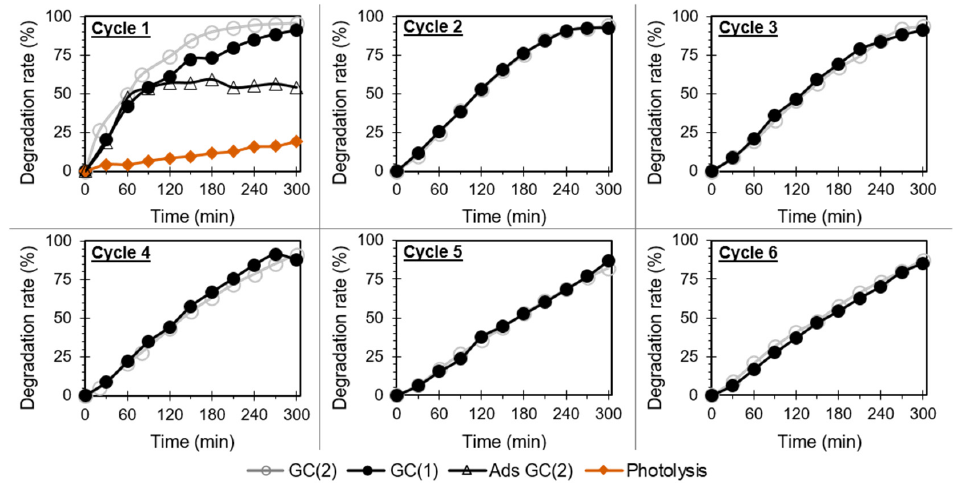
Figure 4. Photolysis degradation rate, adsorption rate in the dark (Ads), and photocatalysis degrada- tion rate as a function of time for MO under artificial solar light in the presence of GC(2) or GC(1) for subsequent experiment cycles.